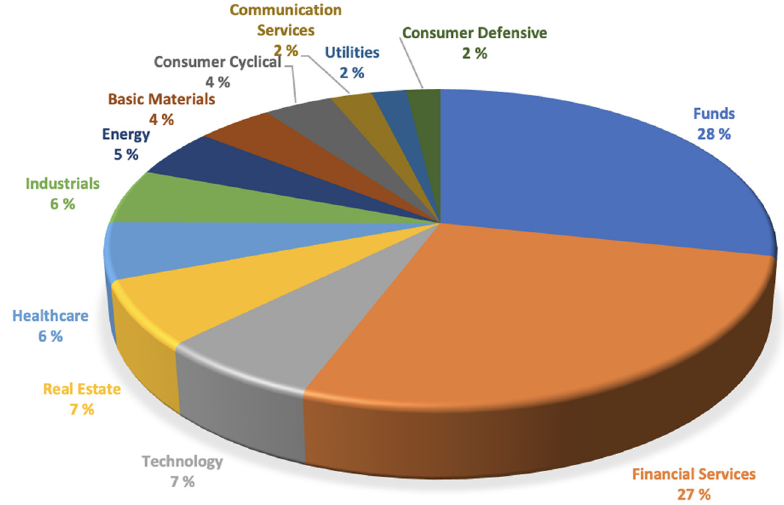
Figure 2: Distribution of highest out - degree stocks by sectors for all considered